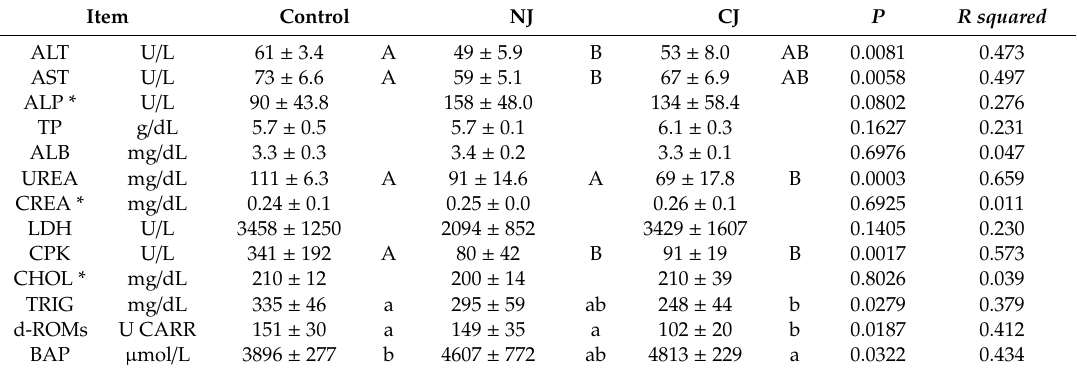
Table 3. Blood chemistry parameters and oxidative status of the mice after 28 days of